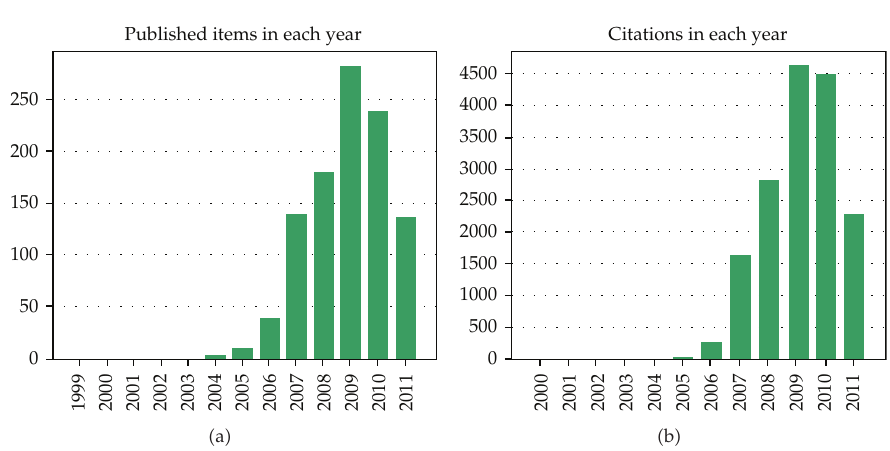
Figure 1: Number of publications on homotopy perturbation according to web of science, August 20,